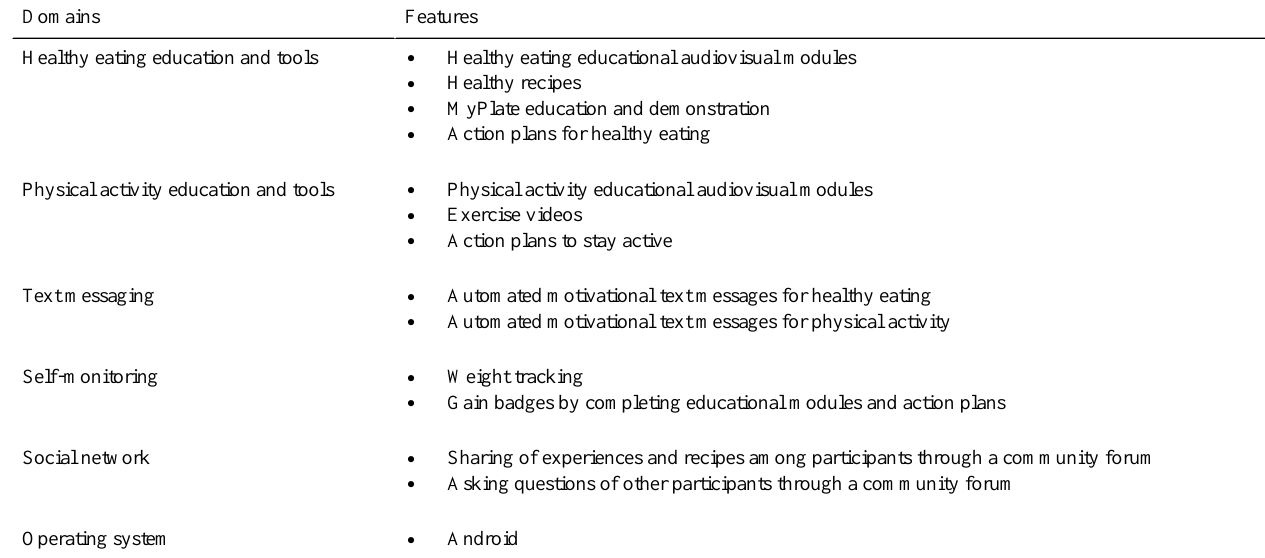
Table 1. Features of the ¡Hola Bebé, Adiós Diabetes!